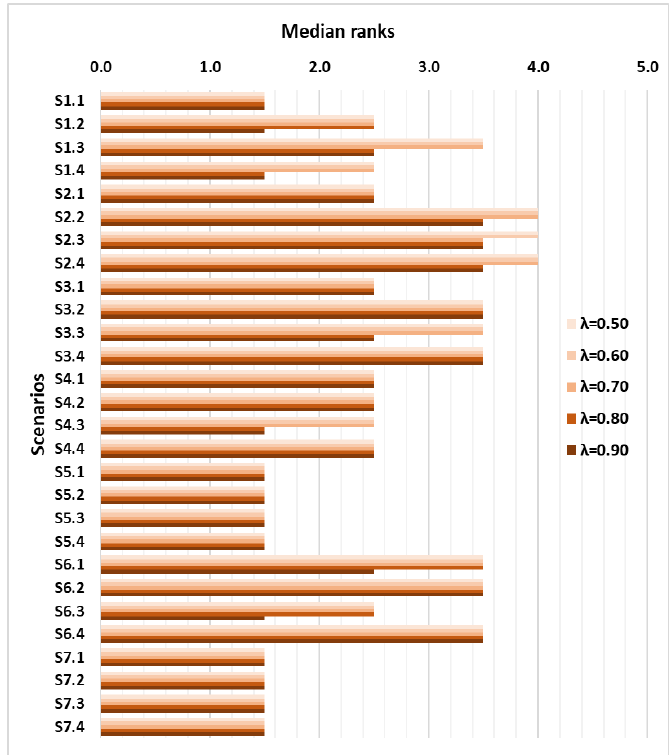
Figure 12. Median ranks for five λ values .